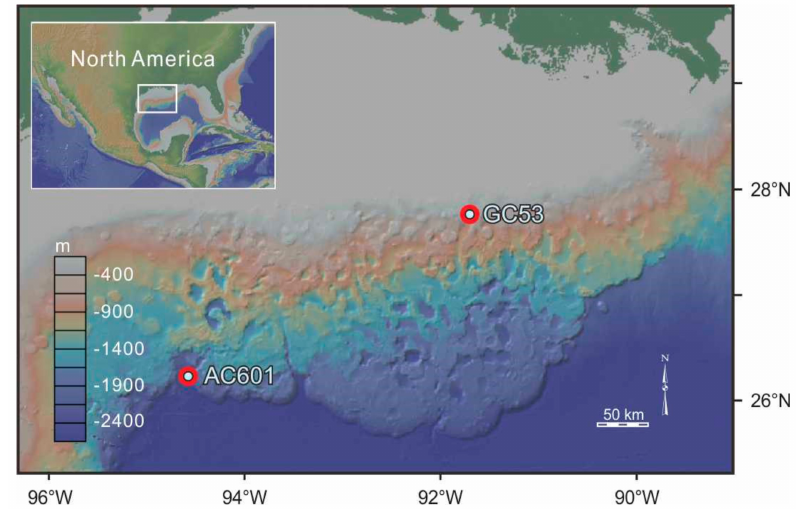
Figure 1. Location of sites GC53 and AC601 in the northern Gulf of Mexico.